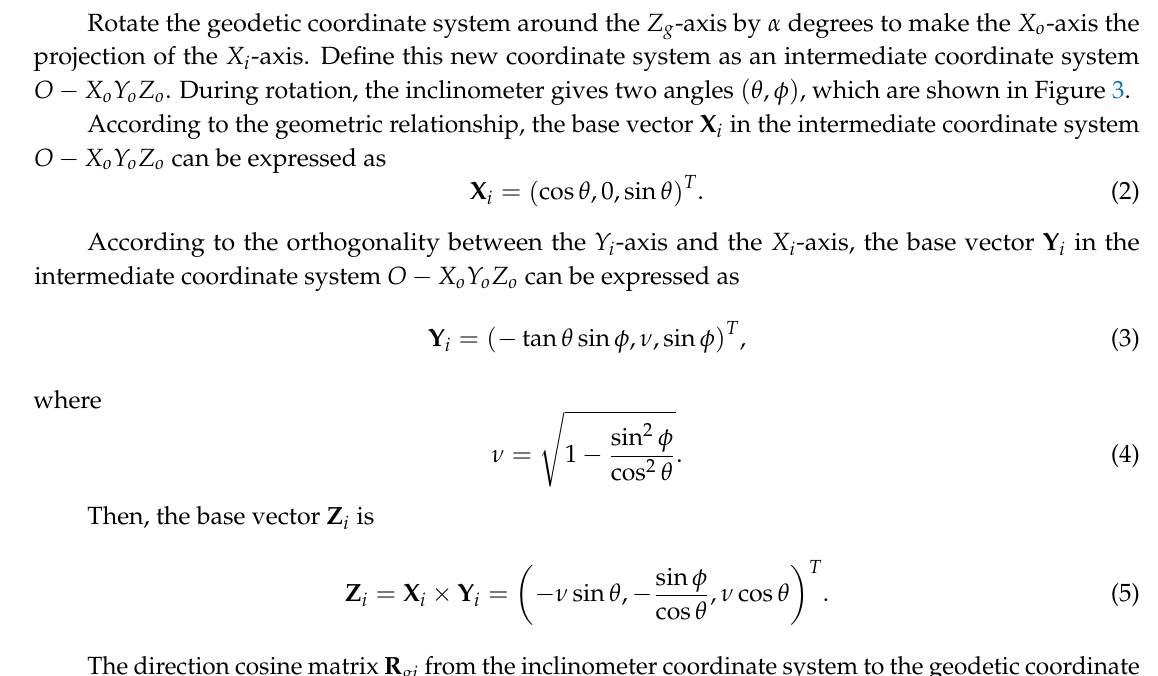
Figure 3. Relationship between the geodetic coordinate system and the inclinometer coordinate system.